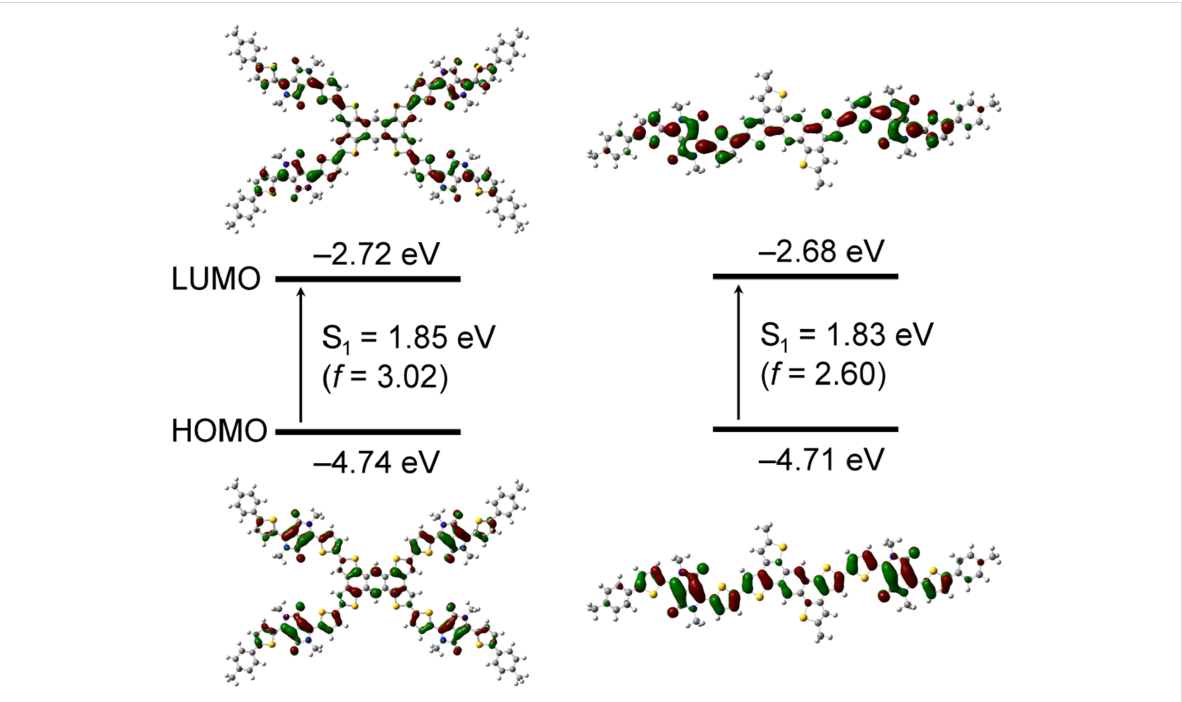
Figure 2: HOMO and LUMO distributions, calculated energy levels, and associated oscillator strengths ( f ) for TTA-DPP4 and TTA-DPP2 calculated at the B3LYP/6-31G(d,p) level. The arrows indicate the first singlet–excited state (S 1 ) transition. The alkyl chains are modified to methyl groups to simplify the